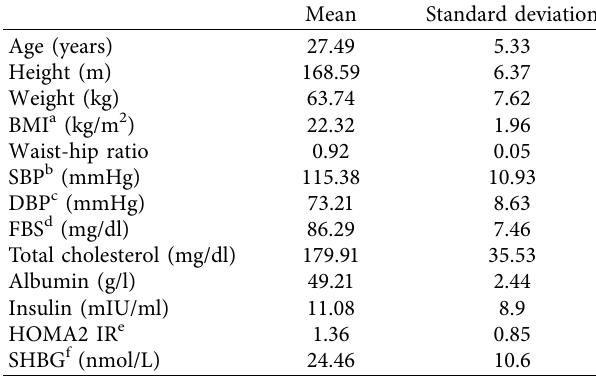
Table 1: Characteristics of study